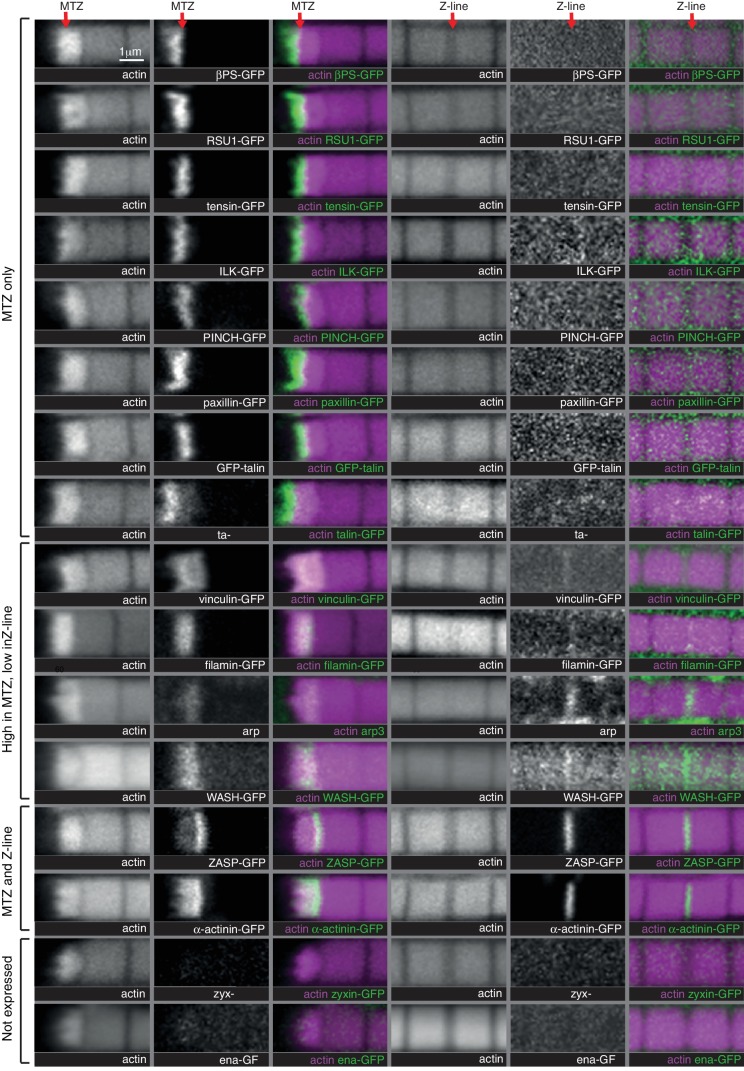
Comparison of IAP distribution at the MTZ versus Z-lines.Distribution of F-actin (white, magenta) and GFP tagged proteins, or antibody staining for arp3, (white, green) in wild type IFMs, showing both the MTZ (left) and a representative Z-line in the middle of the myofibril (right). Note that levels at Z-lines are at much lower levels at Z-lines compare with the MTZ, and therefore images of Z-line distribution were taken at ~10X gain compared to the MTZ images, except ZASP and α-actinin, which were taken at the same settings. The proteins are enriched in different zones, indicated on the left.